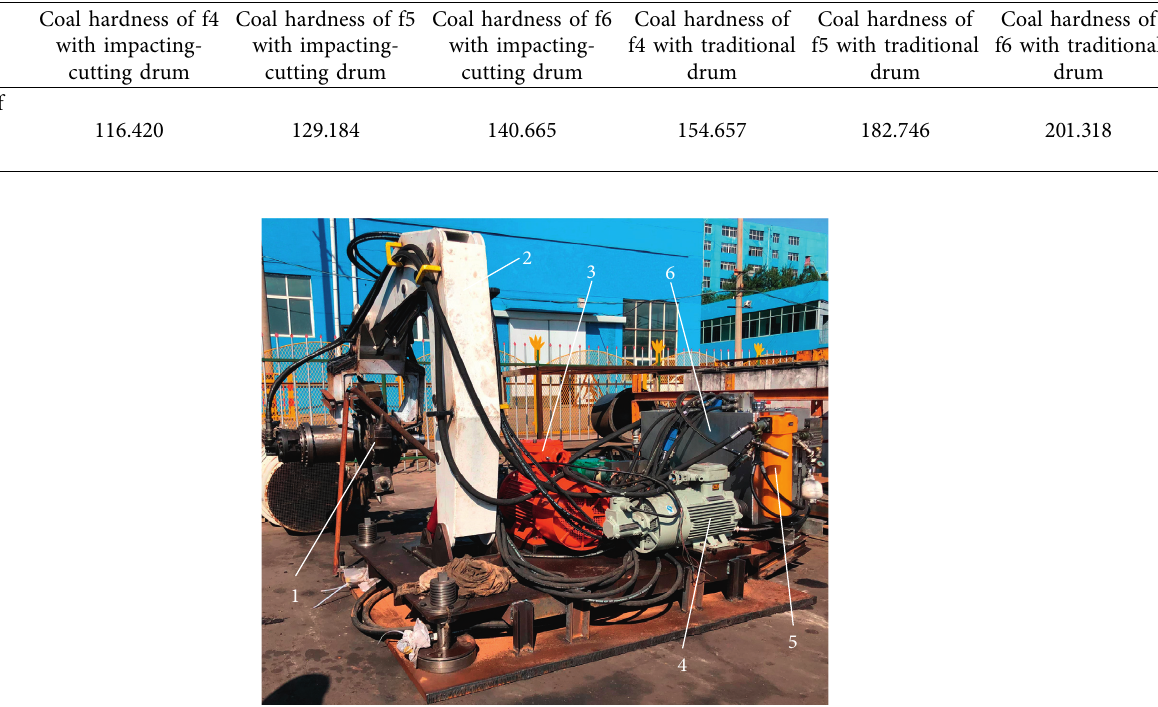
Table 4: Force of each scheme.